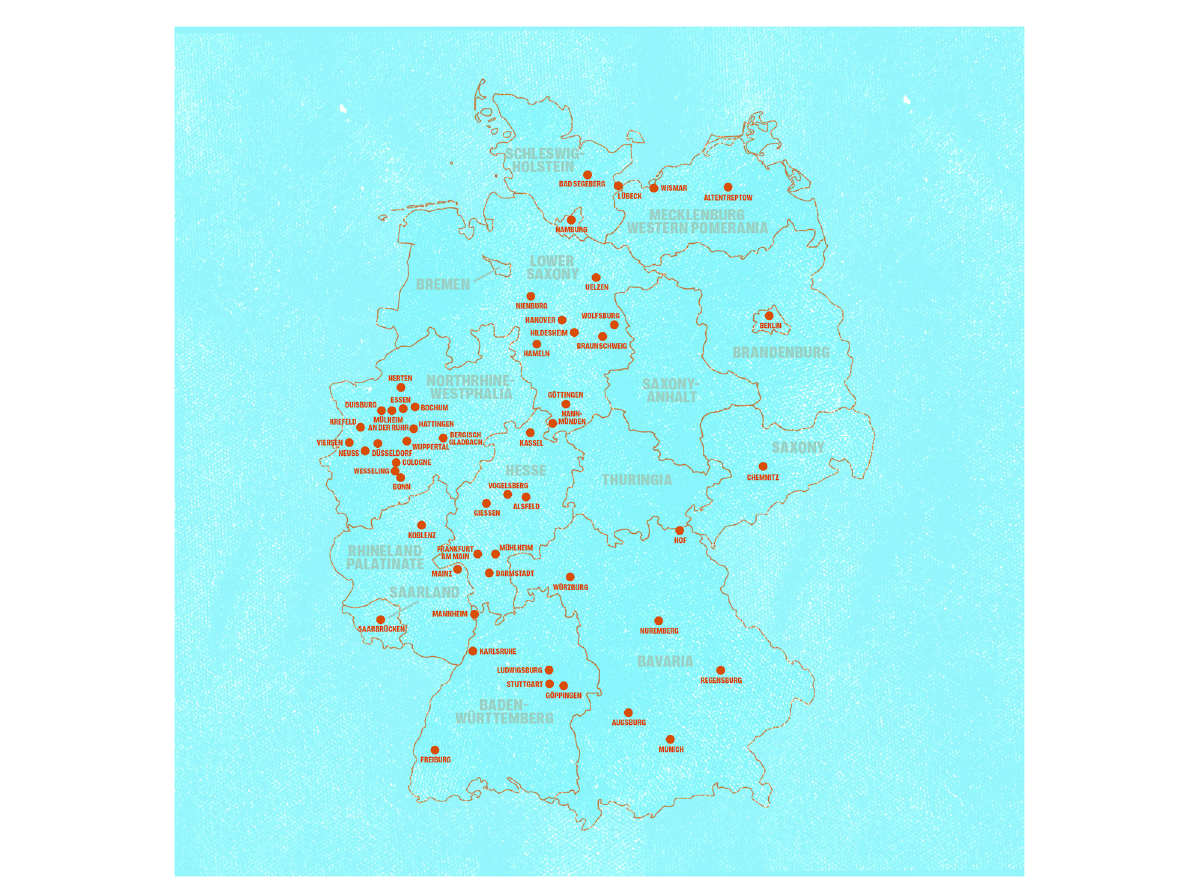
FIGURE4 Map of Germany showing the cities where institution received the printed posters without or with request. From February 2021 until May 2022, a total of 1.754 posters were sent to 163 institutions in 53 cities.